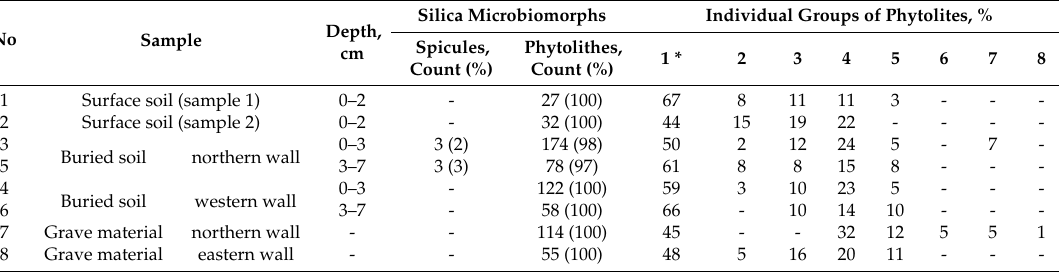
Table 7. Silica microbiomorphs and individual groups of phytolites.